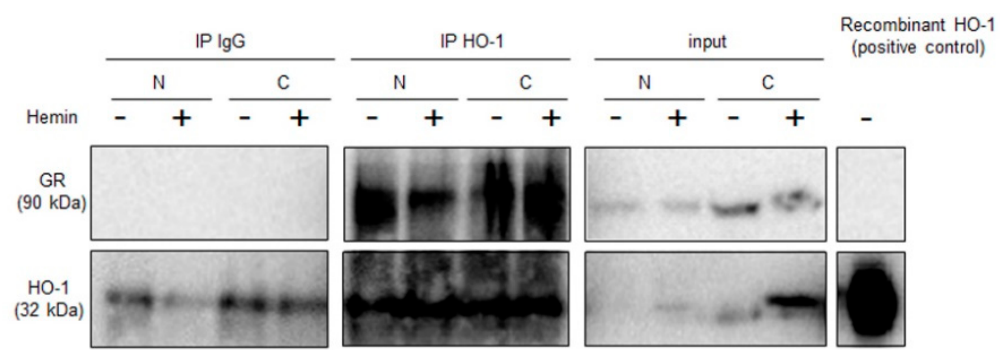
137 Figure 2. HO-1 associates to GR in PC3 cells. PC3 cells were treated with Hemin (80 μ M, 24 h) or PBS as